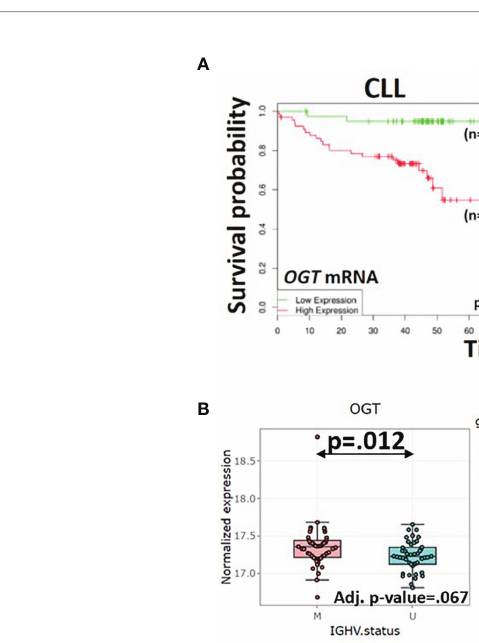
FIGURE 3 | Correlation of OGT mRNA and protein levels in primary blood cancer cells with clinical course. (A) Survival of patients with high (n=66) or low (n=40) expression of OGT in CLL cells (left panel) and survival of diffuse large cell lymphoma patients with rituximab, cyclophosphamide, vincristine, adriamycin, and prednisone (R-CHOP) with high (n=215) or low (n=192) OGT expression in lymph node biopsies (right panel) were respectively compared by in silico analysis of the Herold (72) and Lenz (73) databases using the DRUGSURV bioinformatics analysis tool (http://www.biopro fi ling.de/GEO/DRUGSURV). P-values for differences between the curves are 0.001 (left) and 0.0002 (right). (B) Expression of OGT (left) and OGA (right) proteins in 44 patients with aggressive CLL cells more likely to have an impaired p53 axis as indicated by unmutated IGHV genes (U) and 47 patients with more indolent CLL cells and mutated IGHV genes (M) were obtained with the R Shiny app (http://mozi.embl.de/public/proteomExplorer) provided for exploration of the CLL proteome (74). P-values and adjusted P-values are shown in the graphs and suggest more aggressive CLL cells have a lower OGT/OGA ratio, possibly consistent with relatively lower global O-GlcNAcylated protein